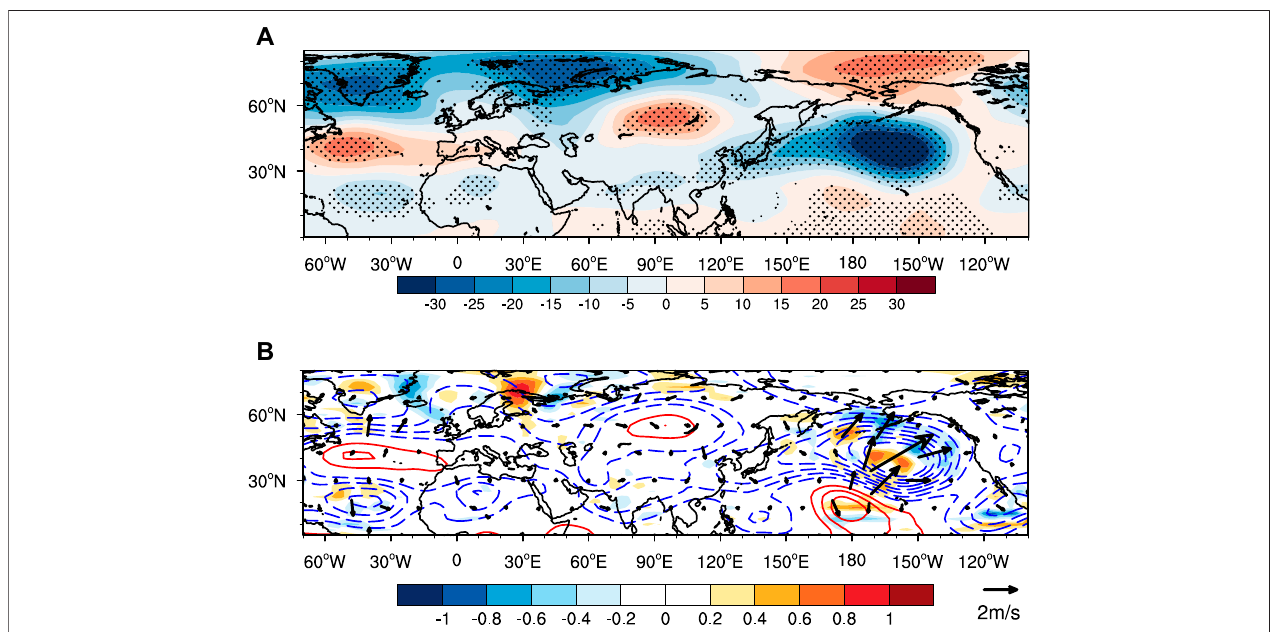
FIGURE 5 | (A) Regression of the winter 500 hPa geopotential height (shading, units: gpm · K − 1 ) on the PDO index from 1979 to 2018. The stippled indicate values exceeding the 95% con fi dence level. (B) As in (A) , but for 500 hPa streamfunction (contour, units: 106 m 2 · s − 1 · K − 1 , intervals are 0.5, from − 4 to 4) and the streamfunction ’ s wave fl ux (vector; units: m 2 · s − 2 ) and the divergence of wave fl ux (shading; units: 10 − 5 m · s − 2 ).